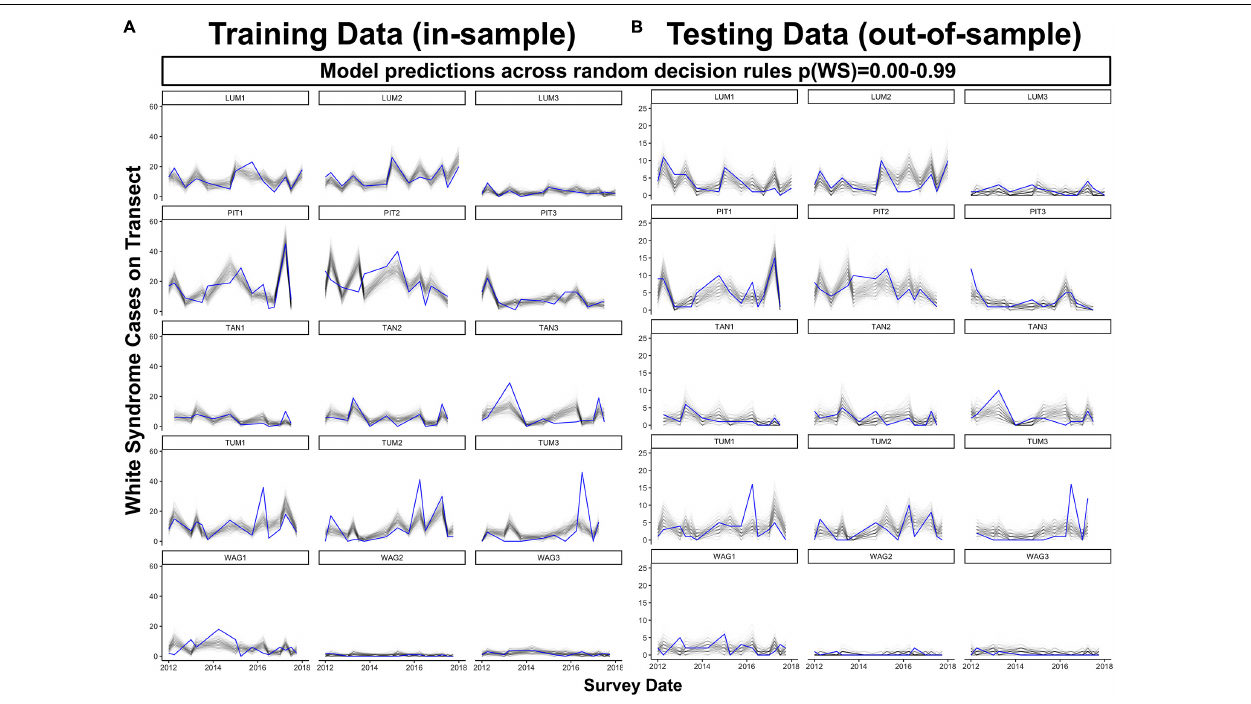
FIGURE 7 | Predicted (black) and observed (blue) total WS cases per transect through time for both model training data (A) , in-sample) and reserved model testing data (B) , out-of-sample) across 1000 colony-scale model realizations using decision rules randomly selected from a uniform distribution ranging from 0.00 to 0.99. For plotting clarity, 250 of the total 1000 model realizations are